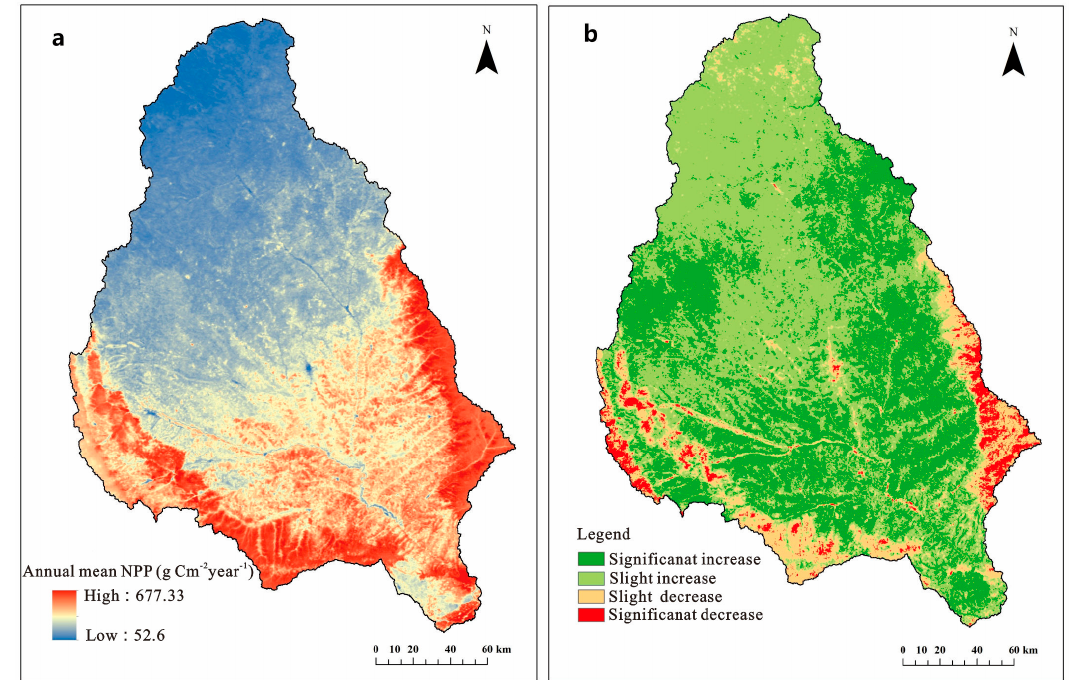
Figure 4. Spatial pattern of the mean NPP ( a ) and the change trend in the NPP ( b ) in the Jinghe River basin from 2000 to 2014.